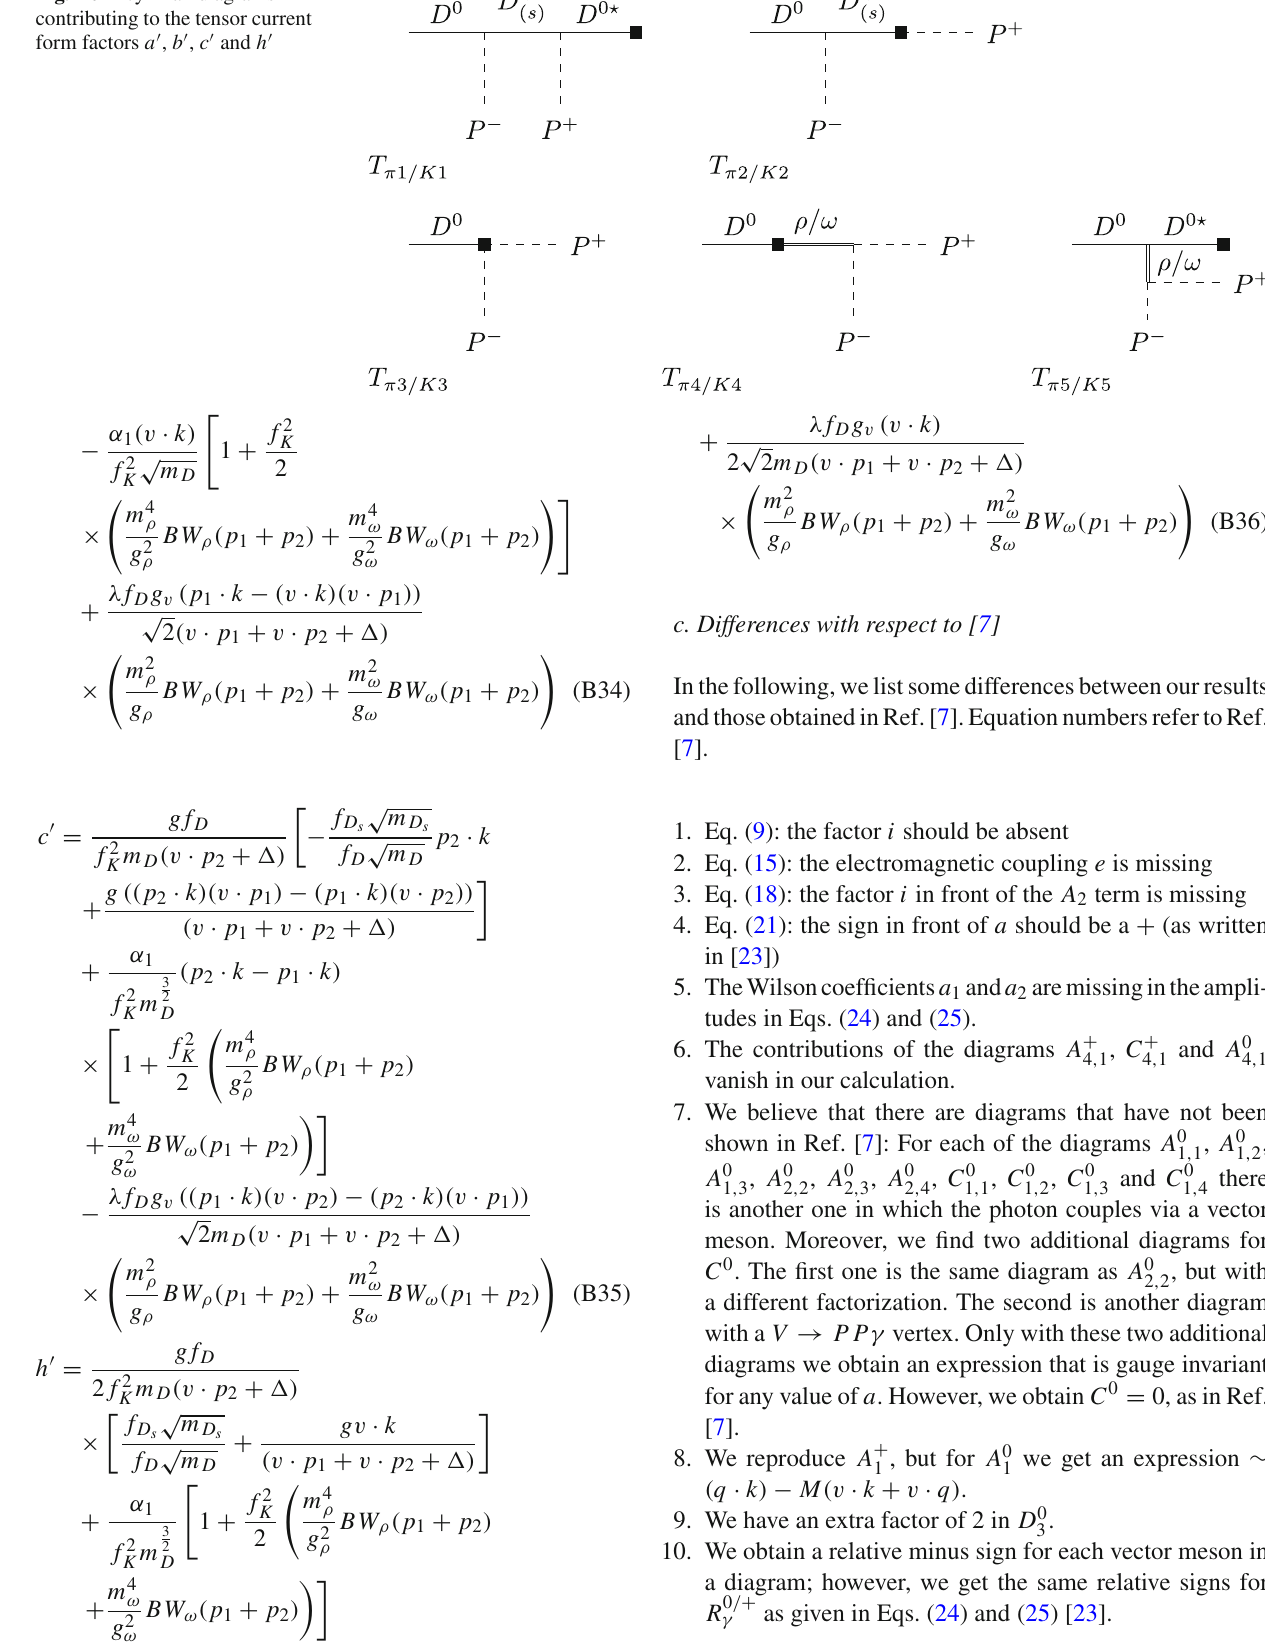
contributing to the tensor current form factors a (cid:7) , b (cid:7) , c (cid:7) and h